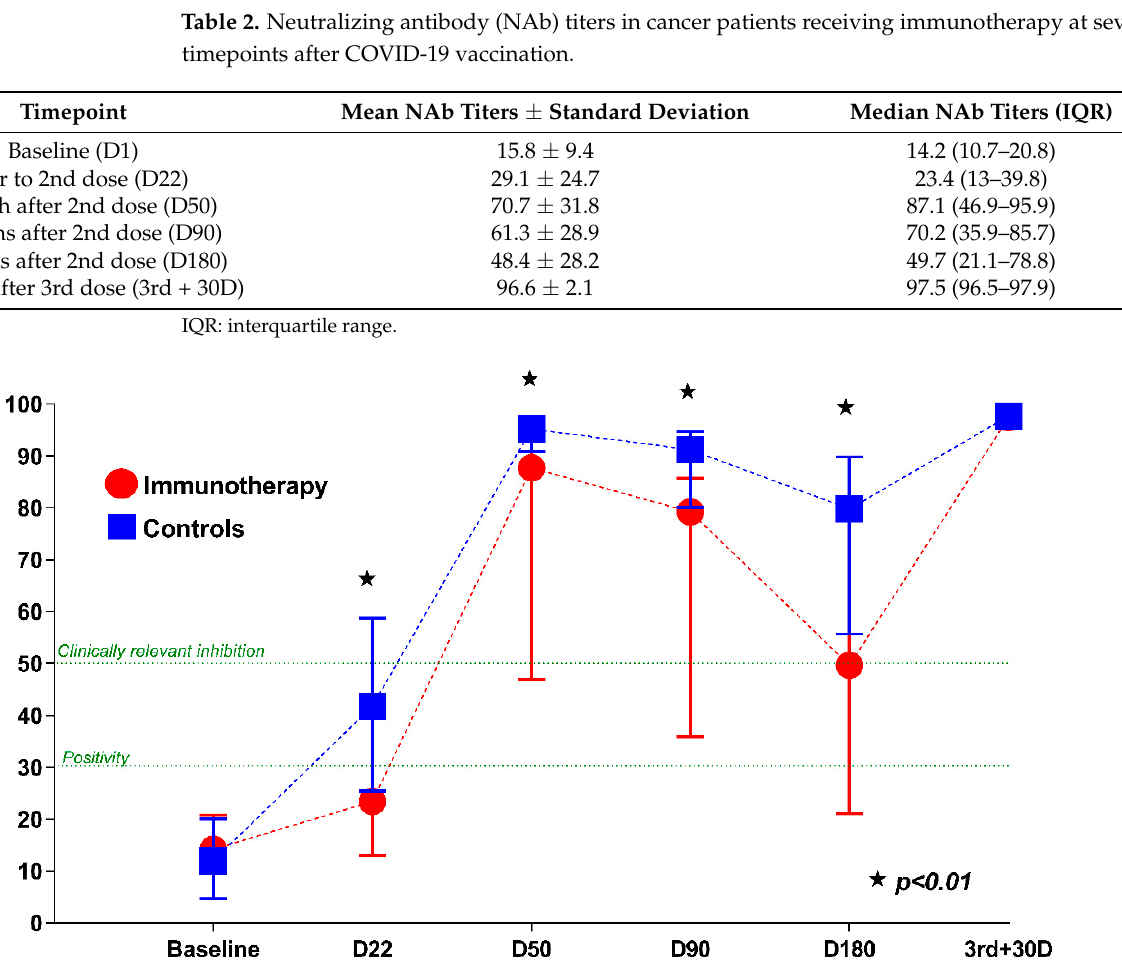
Figure 1. Kinetics of neutralizing antibodies (NAbs) in cancer patients receiving immunotherapy and matched controls at several timepoints after COVID-19 vaccination. The asterisk ( ★ ) denotes a statistically significant difference between the sixth month levels and the previous timepoints ( p < 0.01).